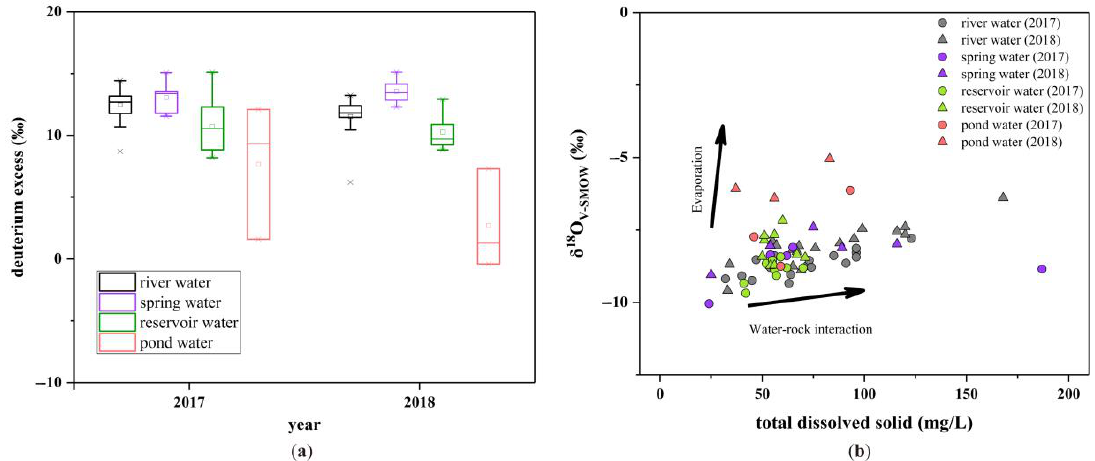
Figure 4. ( a ) Deuterium excess ( d -excess) values of di ff erent types of water samples in the study area. Figure 4. (a) Deuterium excess ( d -excess) values of different types of water samples in the study area. ( b ) Total dissolved solid (TDS) versus δ 18 O of water (b) Total dissolved solid (TDS) versus δ 18 O of water samples